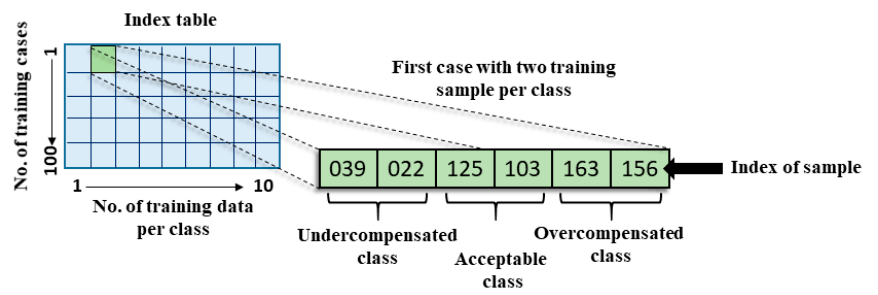
Figure 5. The index table.